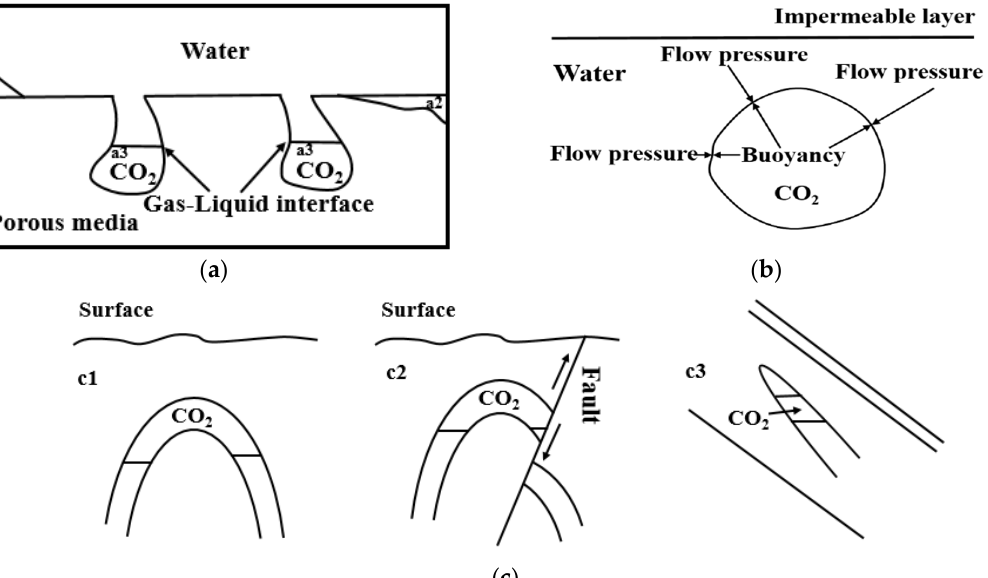
Figure 2. Schematic diagram of CO 2 storage mechanism in saline aquifers: ( a ) residual trapping (( a1 ) dissolved trapping; ( a2 ) mineralization trapping; ( a3 ) residual trapping); ( b ) hydrodynamic trapping; ( c ) structural trapping (( c1 ) anticline trapping; ( c2 ) block trapping; ( c3 ) pinch out